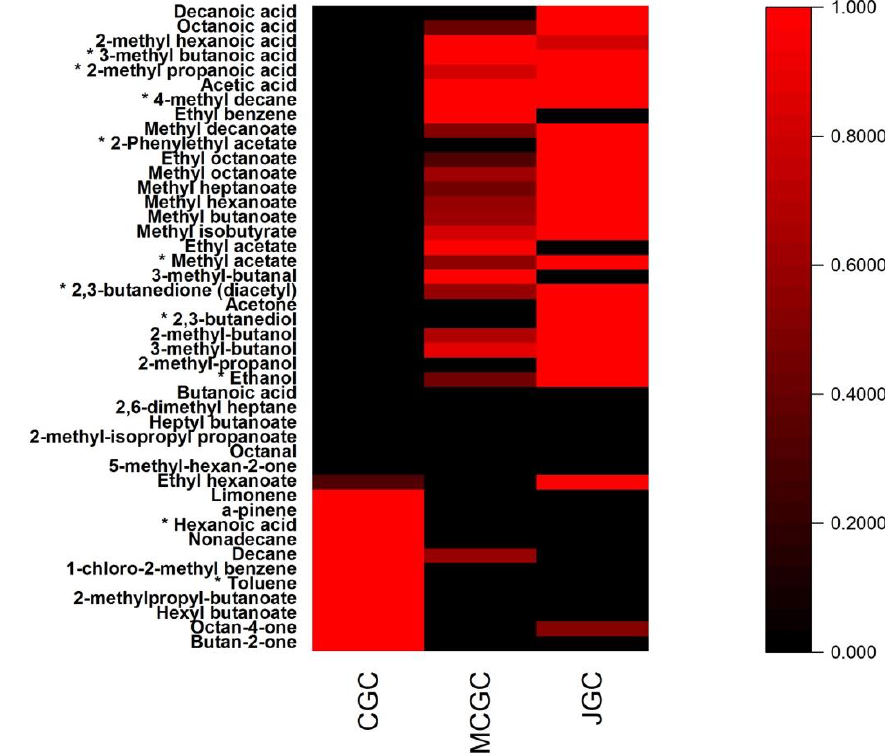
Figure 2. Heatmap representation of the mean values of normalized relative areas obtained for the 44 volatile compounds found in the three typologies of cheeses. * indicates that the volatile compound is a statistical biomarker ( p < 0.01) of the gentian aromatization process in goat cheese. The color gradient scale indicates the intensity of the mean values of normalized areas found in cheeses from low (black) to high (red).